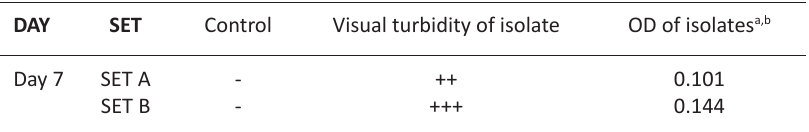
Table 4. Growth of O-2 isolate on M9MM broth supplemented with and without CP PESTANAL ® analytical standard